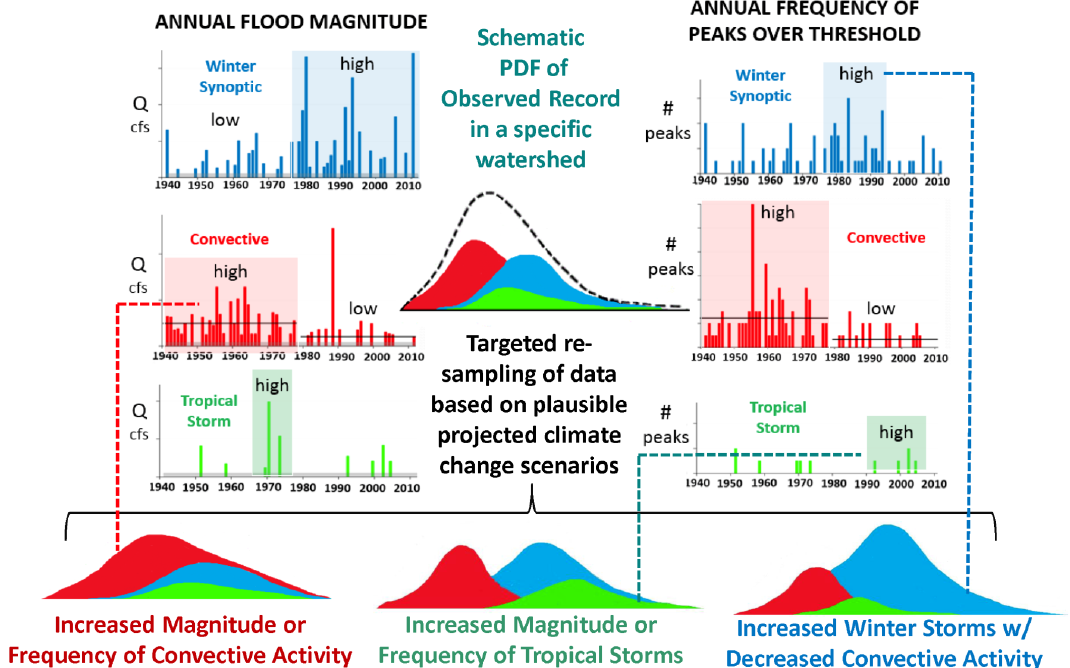
Figure 7. Schematic illustration of a proposed method for the development of process-based flooding scenarios by re-sampling distinctive segments of the observed flood record. Extreme flooding variability often occurs as clusters or episodes of high or low magnitudes of annual flood maxima (left-hand side of figure), and/or high or low frequencies of flood peaks that exceed a defined threshold (right-hand side of figure). To use these modes of variability in scenario development, the flood record can be partitioned into separate time series for each atmospheric-circulation-linked flood-generating process (i.e. winter synoptic, convective, or tropical storm) and then analysed using subjective and objective methods (e.g. change-point analysis) to identify statistically significant and climatically unique episodes of extreme flooding behaviour (shaded segments of flood time series). The magnitude and frequency attributes of the flood peaks in each unique episode can then be iteratively sampled and recombined to simulate new modes of flood-generating behaviour during plausible projected climatic shifts (e.g. increased magnitude and frequency of winter synoptic storms combined with decreased frequency of convective